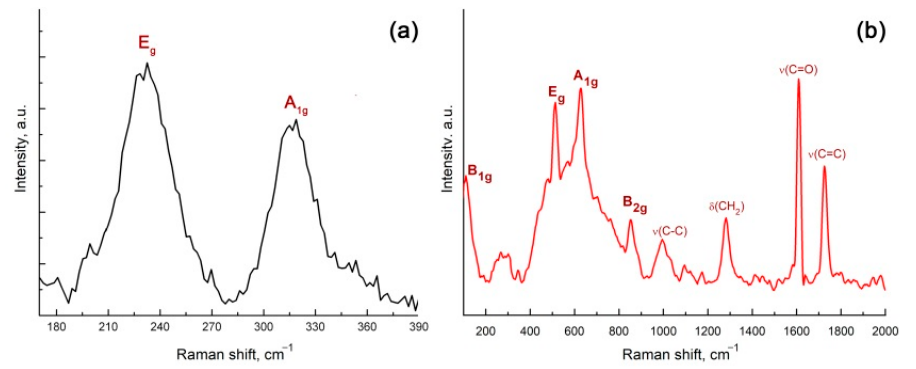
corresponding to the residues of the oleic acid stabilizer used in the synthesis of the SnS 2 nanosheets (Table 1).